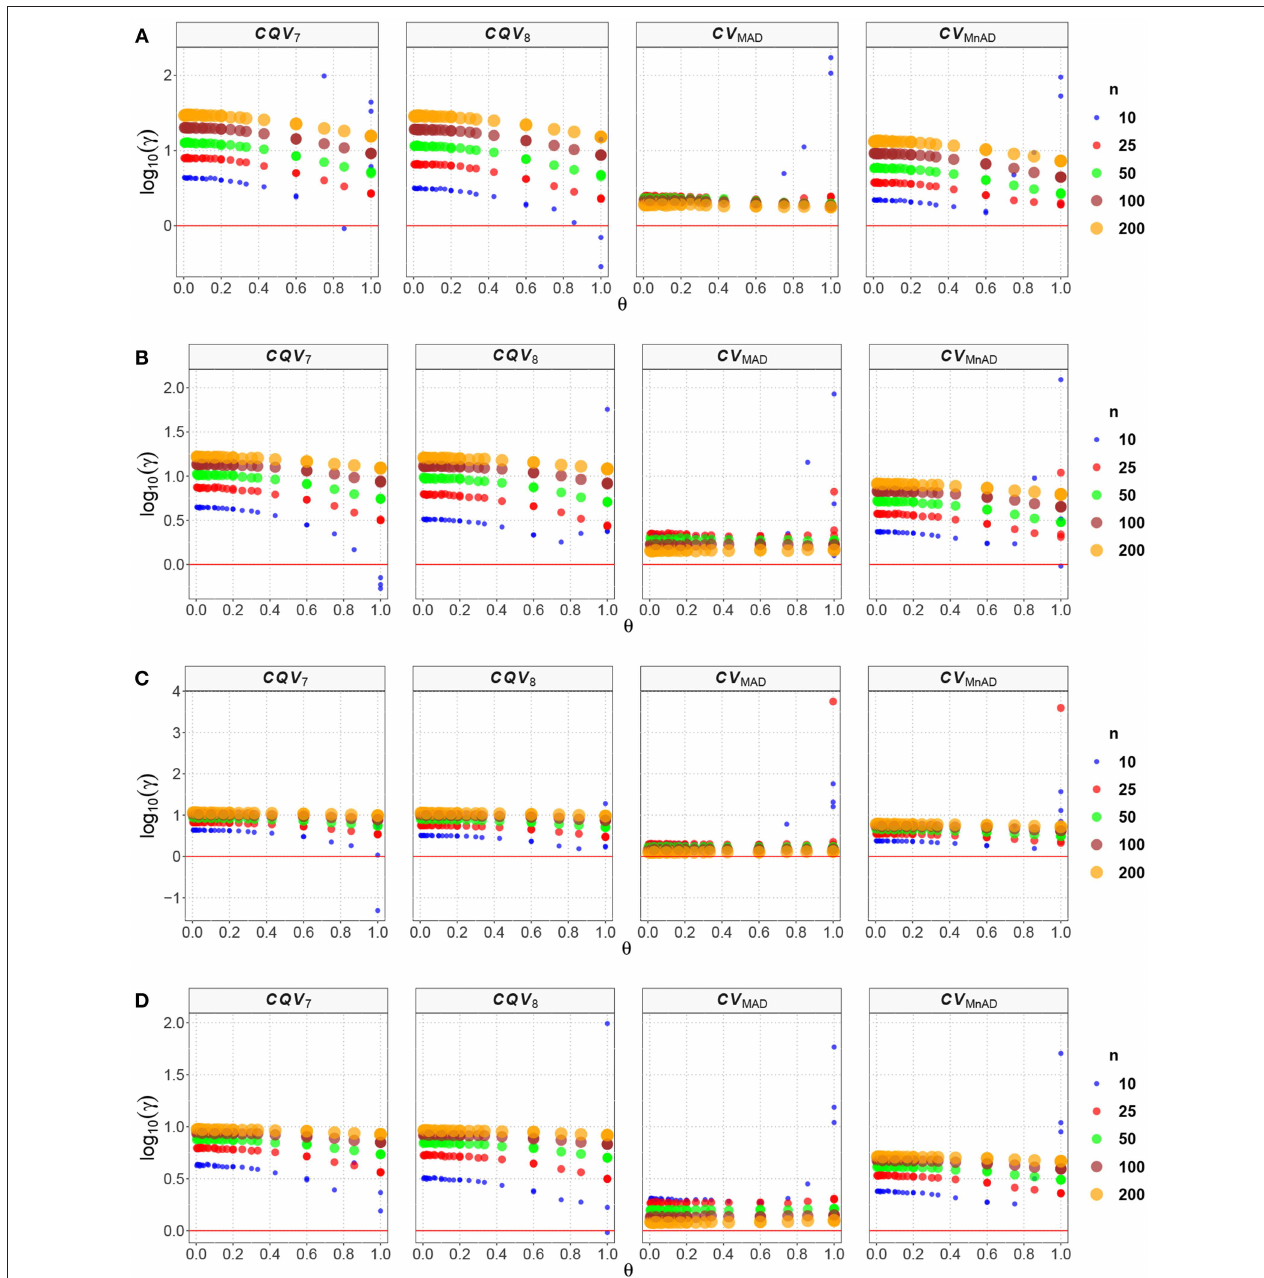
FIGURE 2 | Scatter plots comparing the log 10 ( γ ) accuracy metric as a function of θ scaled-contaminated normal distribution CN ( µ , σ , α , λ ) distribution. Each horizontal panel represents a level of contamination, respectively: (A) α (C) α 15 % , and (D) α 20 % . Here, µ , σ , and λ are defined in section Identification of Simulation Scenarios. = =